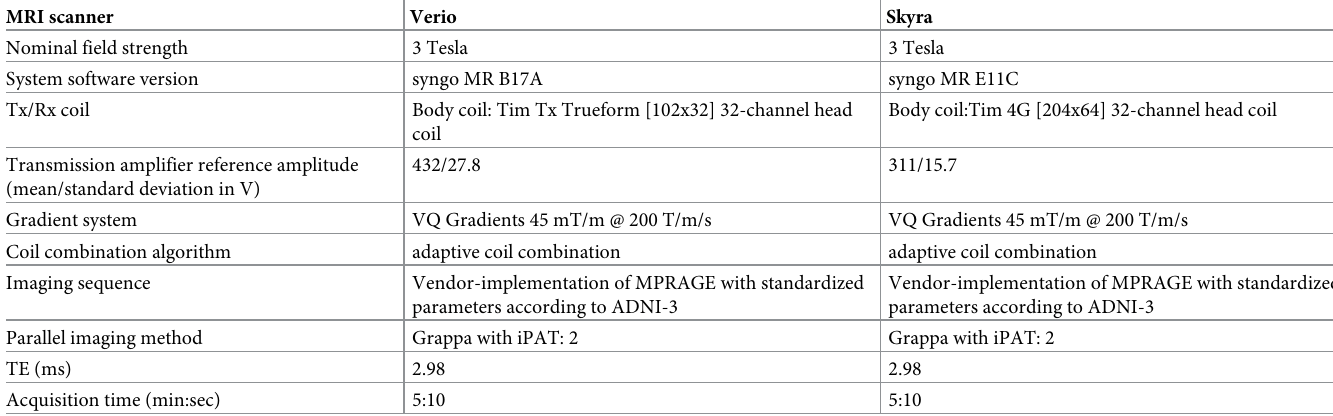
Table 1. Information on hardware, software and acquisition parameters used on the Verio and Skyra